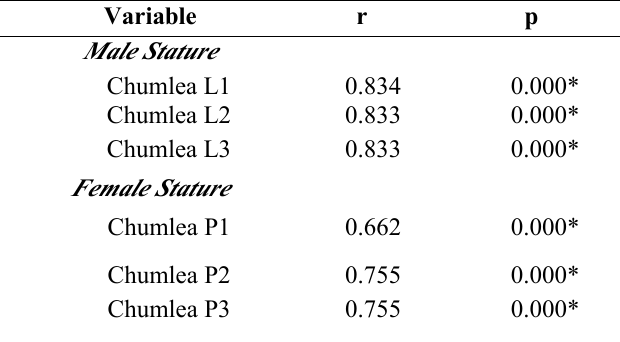
Table 3 Correlation between actual stature and estimated stature using formula r = Pearson Correlation; *Statistically Significant